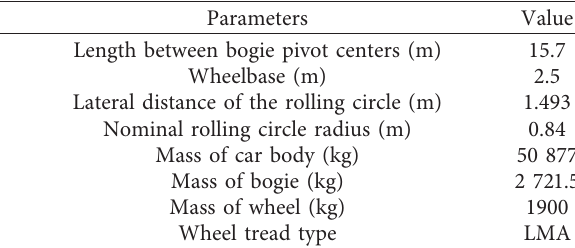
Table 3: Key parameters of type A subway